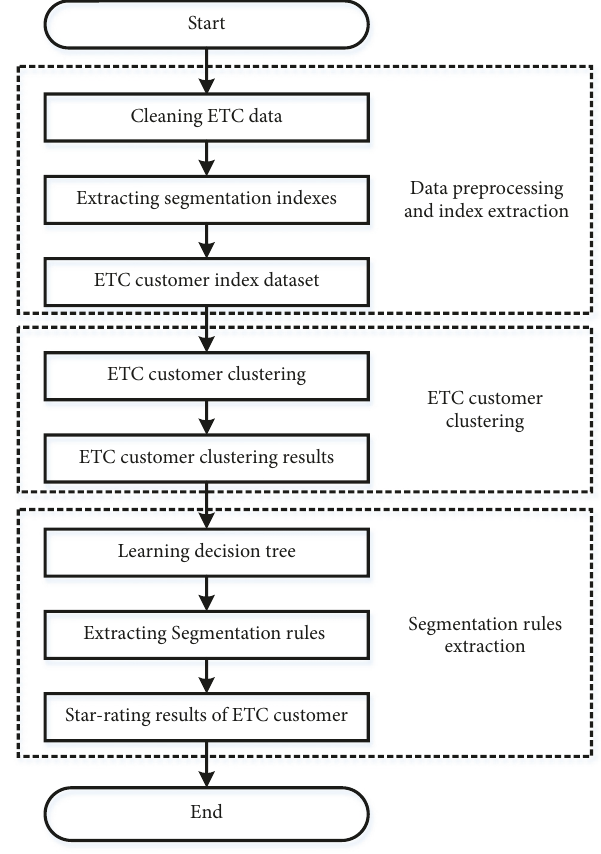
Figure 1: Modeling procedure for ETC customer